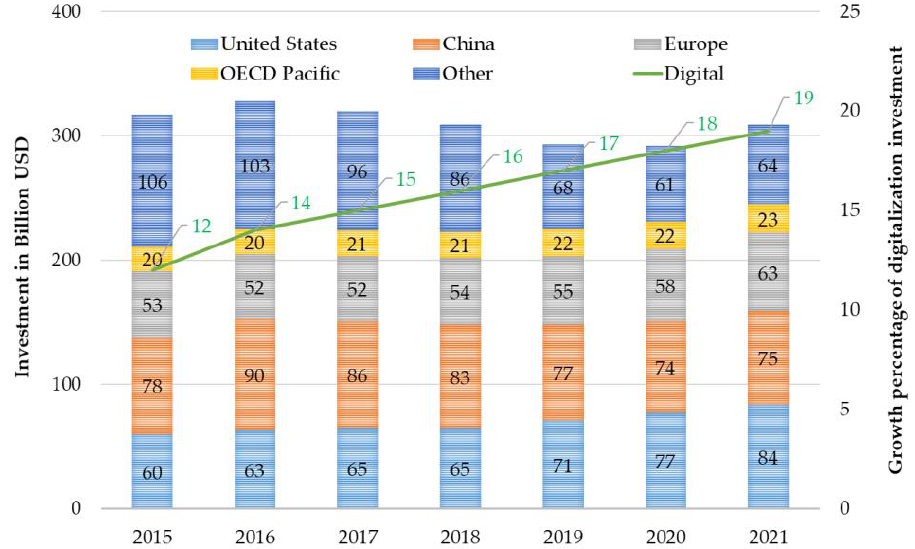
Figure 5. Investment spending on electricity grids, 2015 – 2021 [76].